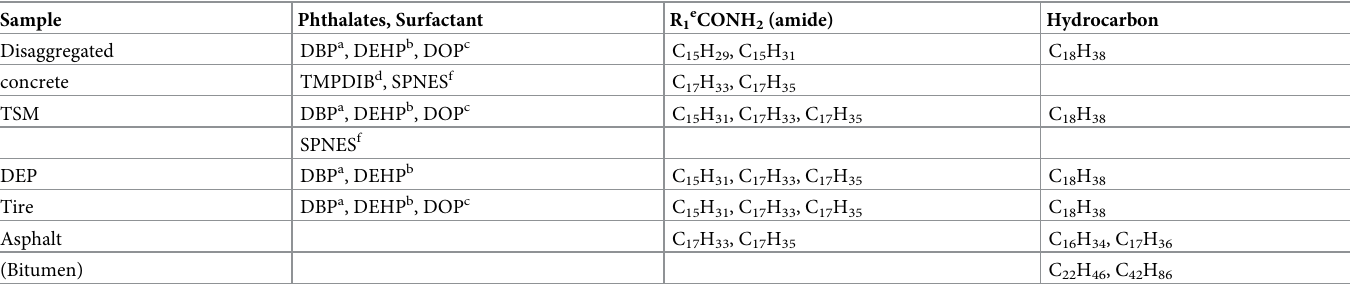
Table 3. Main chemical components, emission sources of the organic components of samples in disaggregated cement concrete, TSM, DEP, tire debris, SPNES and asphalt (bitumen). Sample Phthalates, Surfactant R 1e CONH 2 (amide)